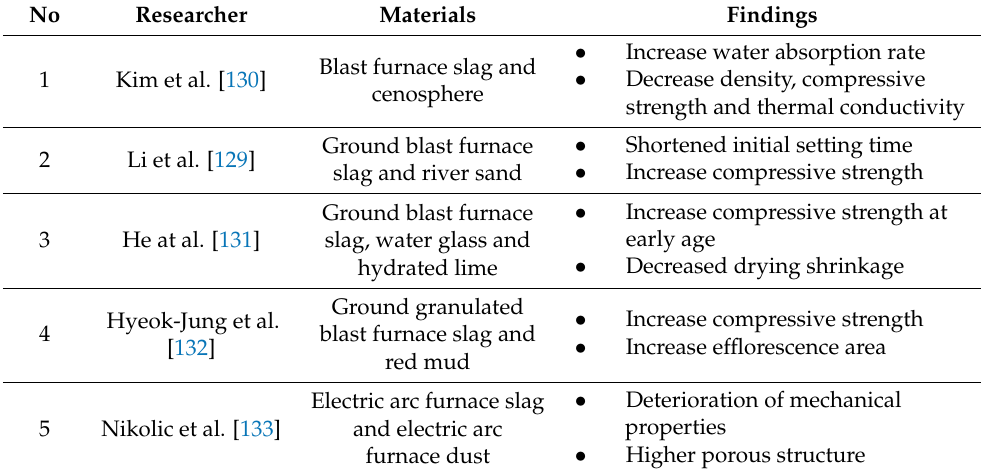
Table 7. Research work utilizing alkali-activated slag cement.